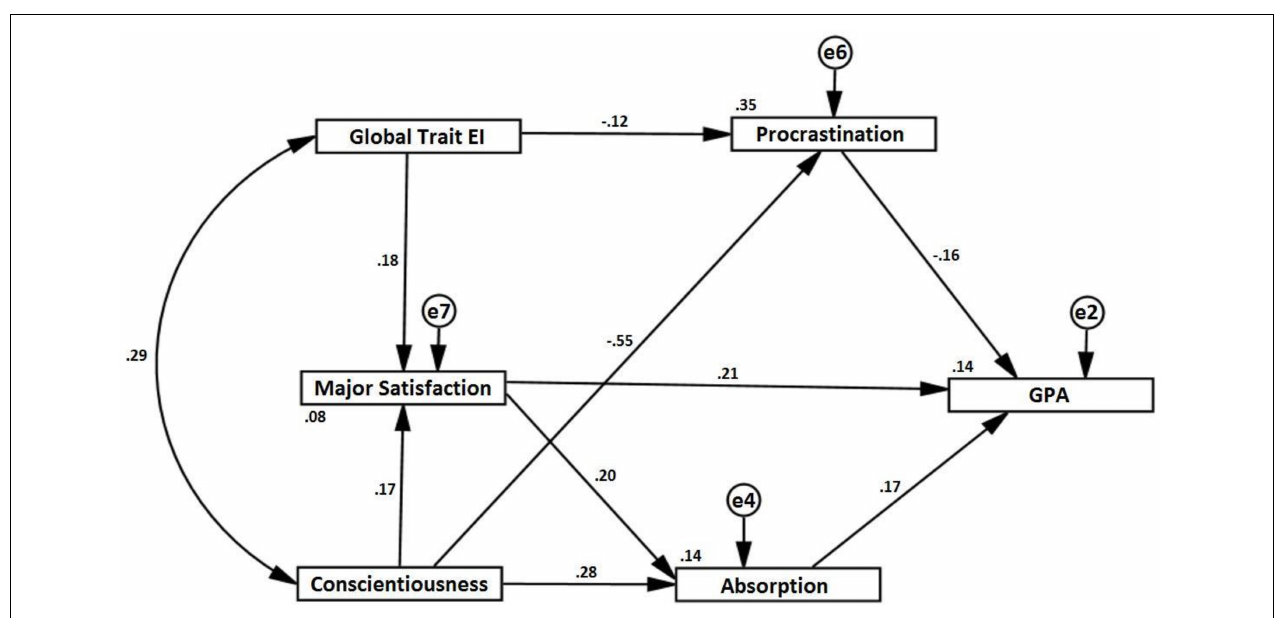
FIGURE 1 | Hypothesized model with the respective path